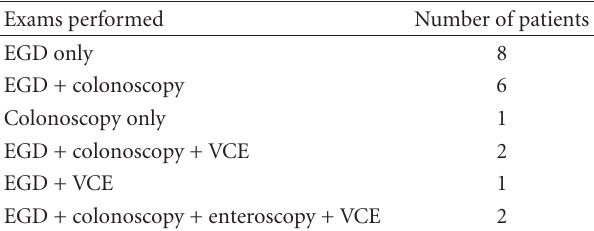
Table 4: Utilization of endoscopic studies by exam type. Exams